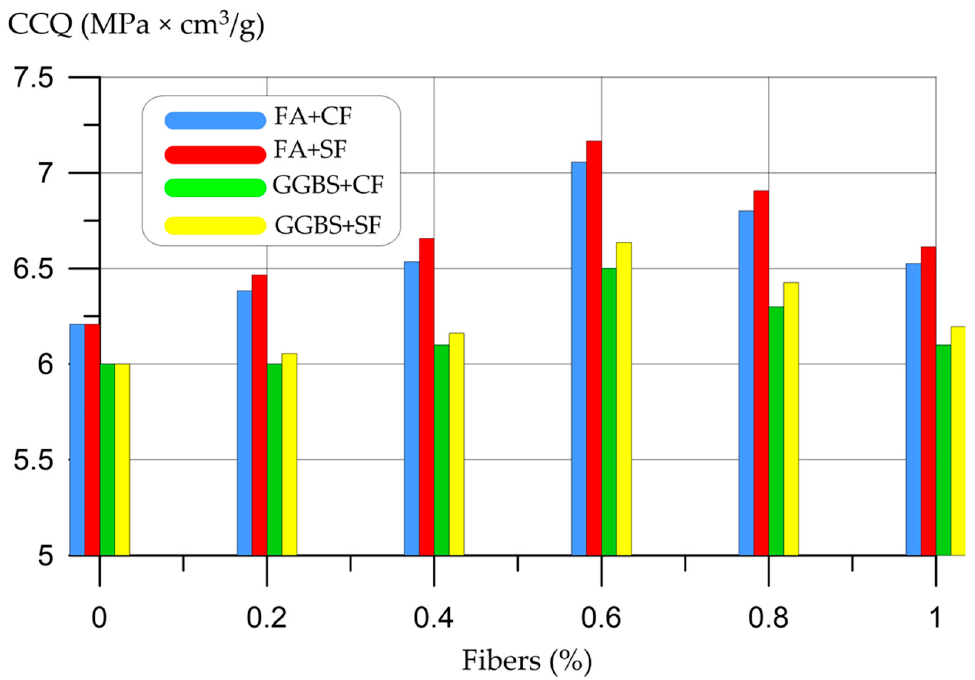
Figure 14. CCQ values of FA- and GGBS-modified aerated concrete with different CF and SF con- tents.